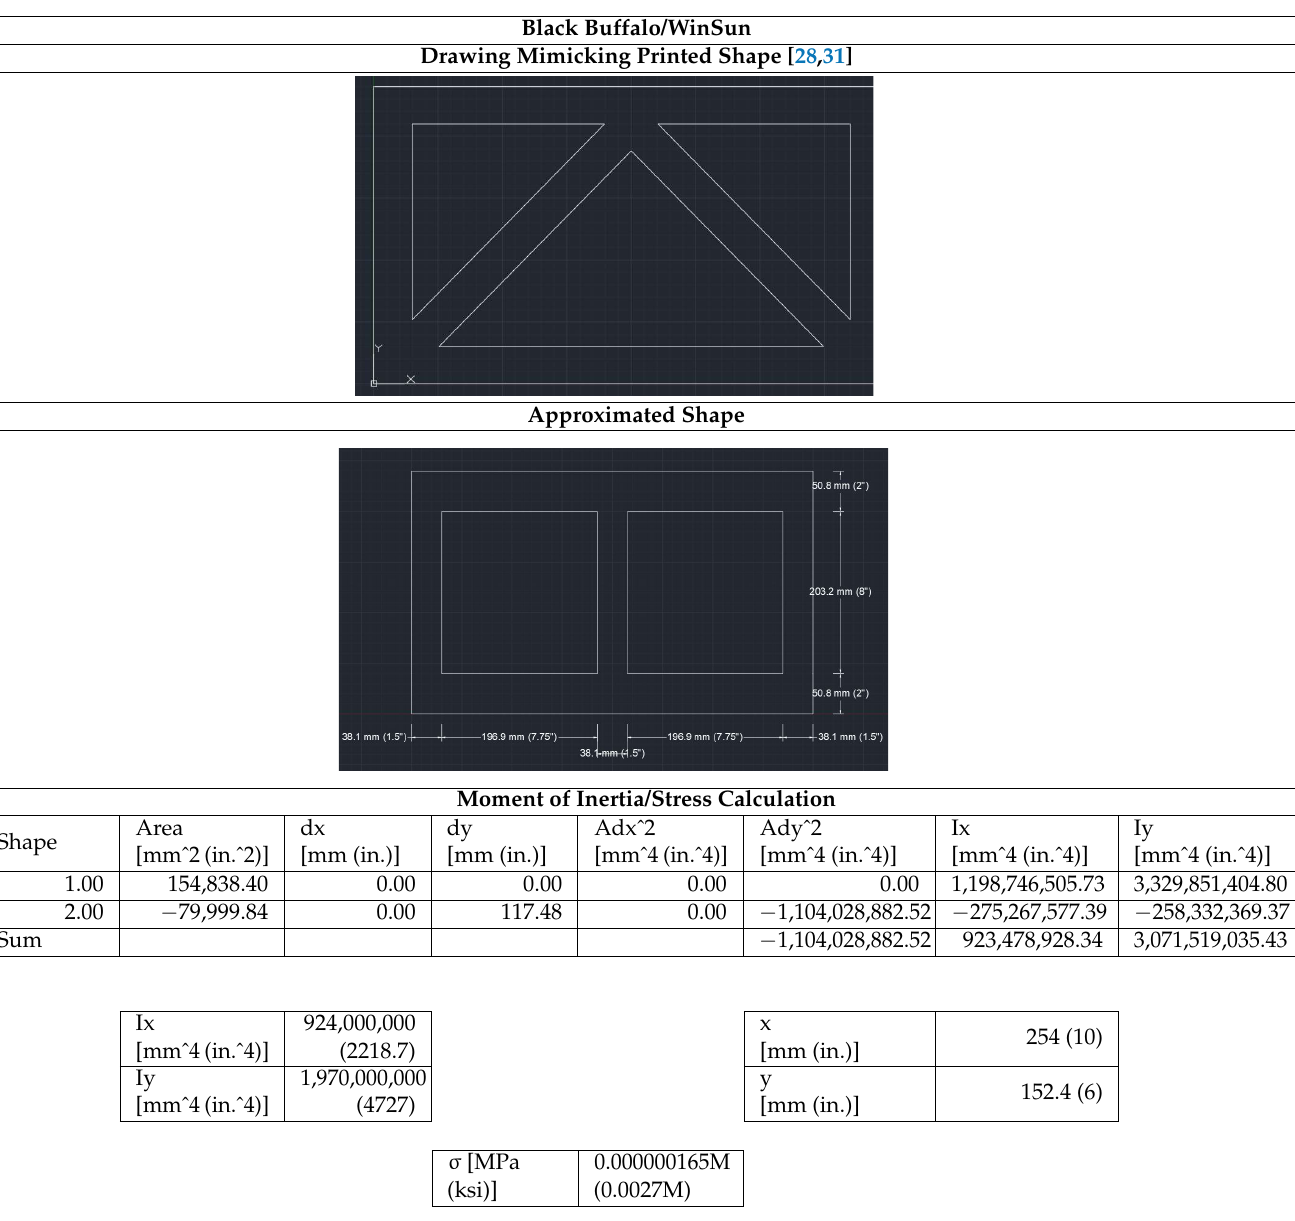
Table A3. Black Buffalo/WinSun wall calculations.